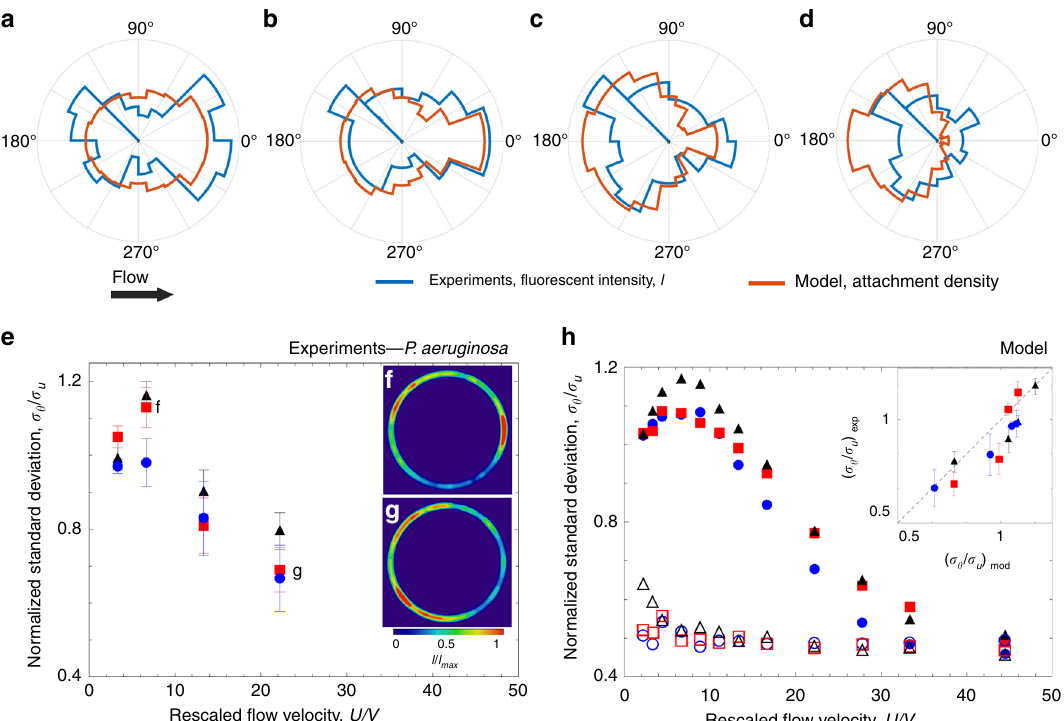
Fig. 5 Fluid velocity modi fi es the angular distribution of bacterial colonization around a pillar. Angular distribution of the fl uorescence intensity, I (blue; experiments after 5 h of fl ow of a diluted suspension of PA14 wt GFP cells) and the simulated attachment density (orange; model) on a 100- µ m pillar for a mean rescaled fl ow velocity U/V of 3.3 ( a ), 6.6 ( b ), 13.3 ( c ) and 22.2 ( d ). e Normalized standard deviation σ θ / σ u for motile PA14 wt bacteria as a function of the rescaled fl ow velocity, U/V , for pillars of diameter 50 µ m (blue circles), 100 µ m (red squares) and 200 µ m (black triangles). (Insets) Intensity distribution I of PA14 wt cells, normalized by the maximum value ( I max ), attached to a 100- µ m pillar at U/V = 6.6 ( f ) and U/V = 22.2 ( g ). At moderate fl ows, preferential colonization occurs on the leeward side of the pillar. Flow direction is from left to right. h Normalized standard deviation σ with the model as a function of U/V and for the same pillar dimensions as in e . Results for motile cells ( fi lled symbols) and for nonmotile cells (open symbols) are shown. (Inset) σ θ / σ u of the experimental intensity angular distribution as a function of σ θ / σ u from the model for different pillar diameters. The dashed line represents y = x . Error bars correspond to the standard error of the